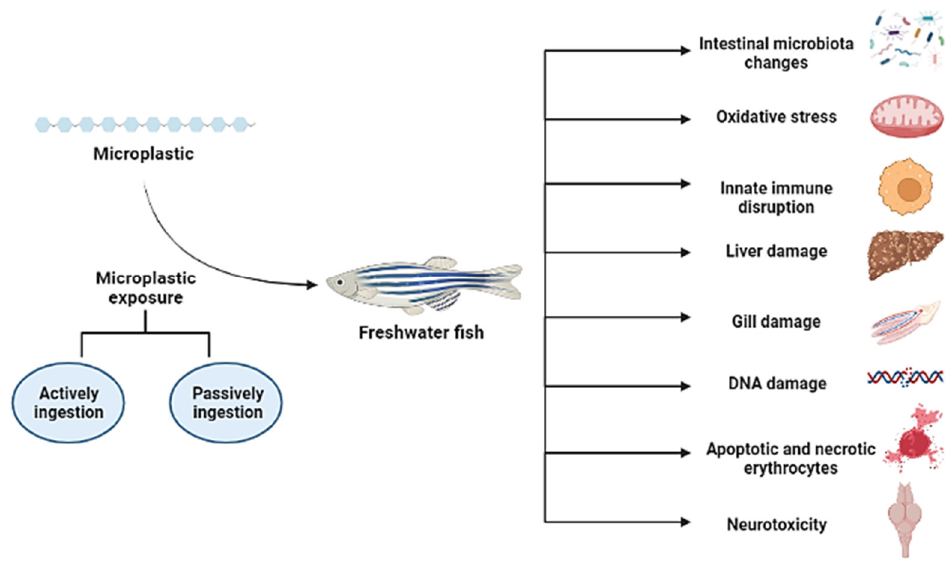
Figure 4. The main histological, biochemical, and molecular modifications induced by microplastic in freshwater fishes. Image created in https://biorender.com/ (accessed on 9 August 2022).